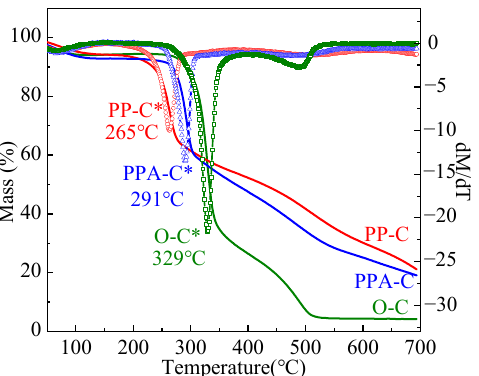
Figure 8. TG–DTG (*) of cotton fabrics at 10 °C/min heating rate (air atmosphere).